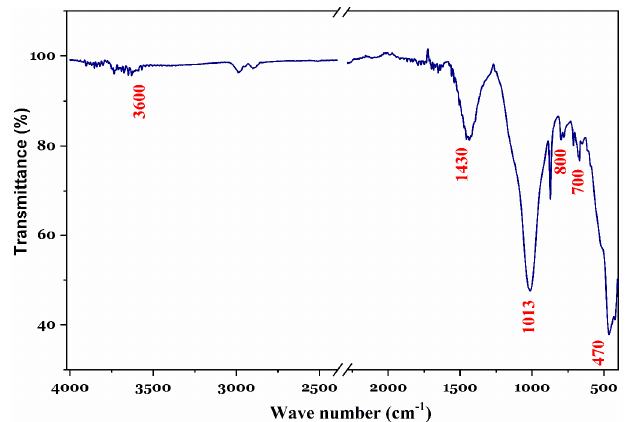
Figure 2. FTIR spectrum of DSD